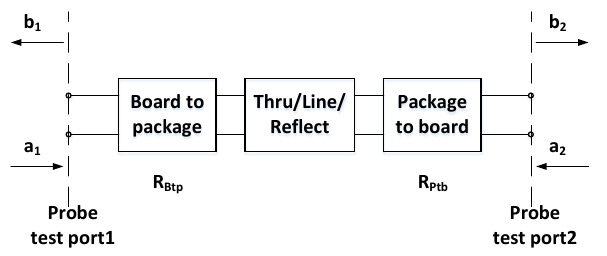
Figure 8. Test block diagram based on the TRL calibration technique.